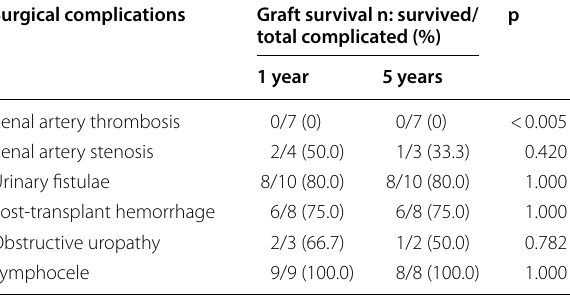
n survived grafts/total complicated (% percentage of survived of total complicated)